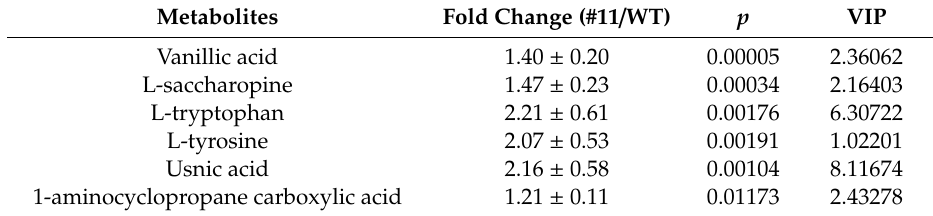
Table 1. Di ff erentially expressed metabolites between WT and MoSDT1 transgenic